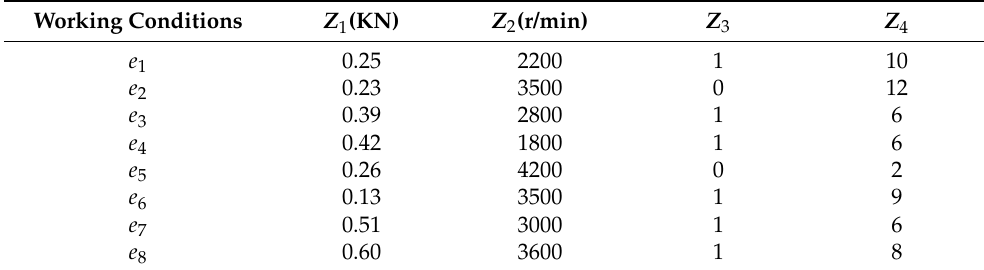
Table 1. The specific value of parameters in the 8 working conditions.